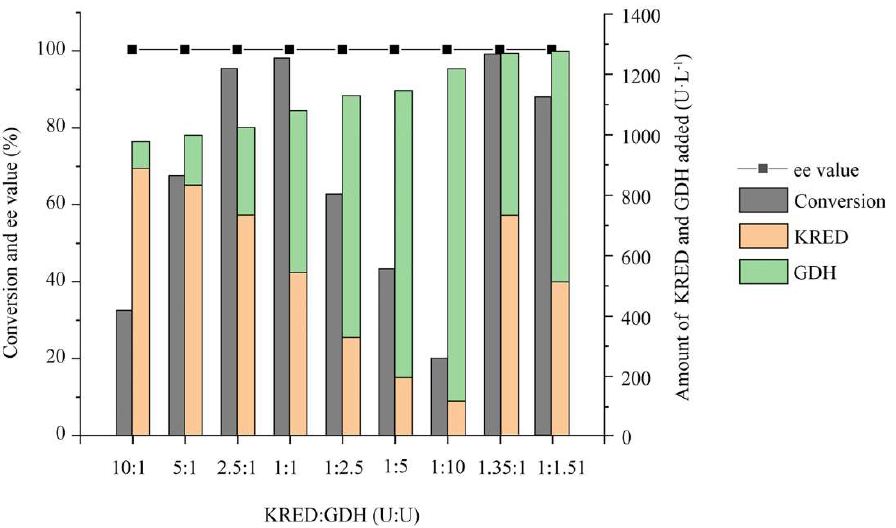
Figure 3. Asymmetric synthesis of ( S )−NBHP catalyzed by various ratios of KRED to GDH. The activity ratios of KRED to GDH in E. coli /pET28−K−rbs−G and E. coli /pETDuet−K−G were 1.35:1 and 1:1.51, respectively. All values of conversion are means from three individual measurements and standard deviations did not exceed 5%.